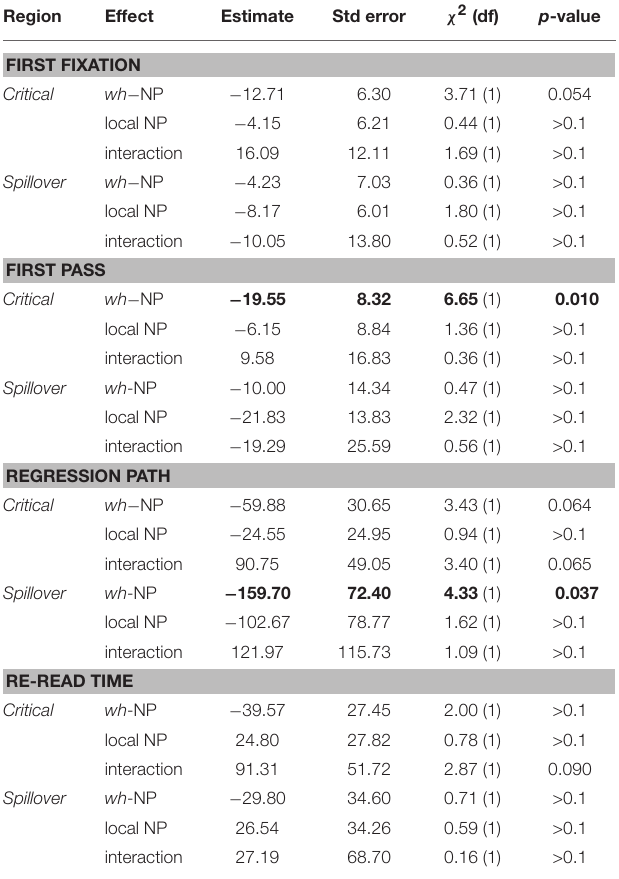
TABLE 2 | Combined ANOVA and LME results for Experiment 1. Region